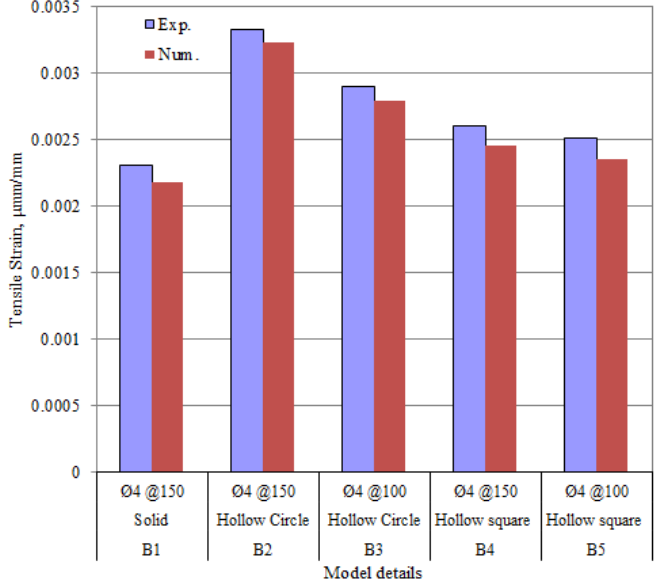
Figure 21. Comparison of experimental and numerical tensile strains of all RC beams.